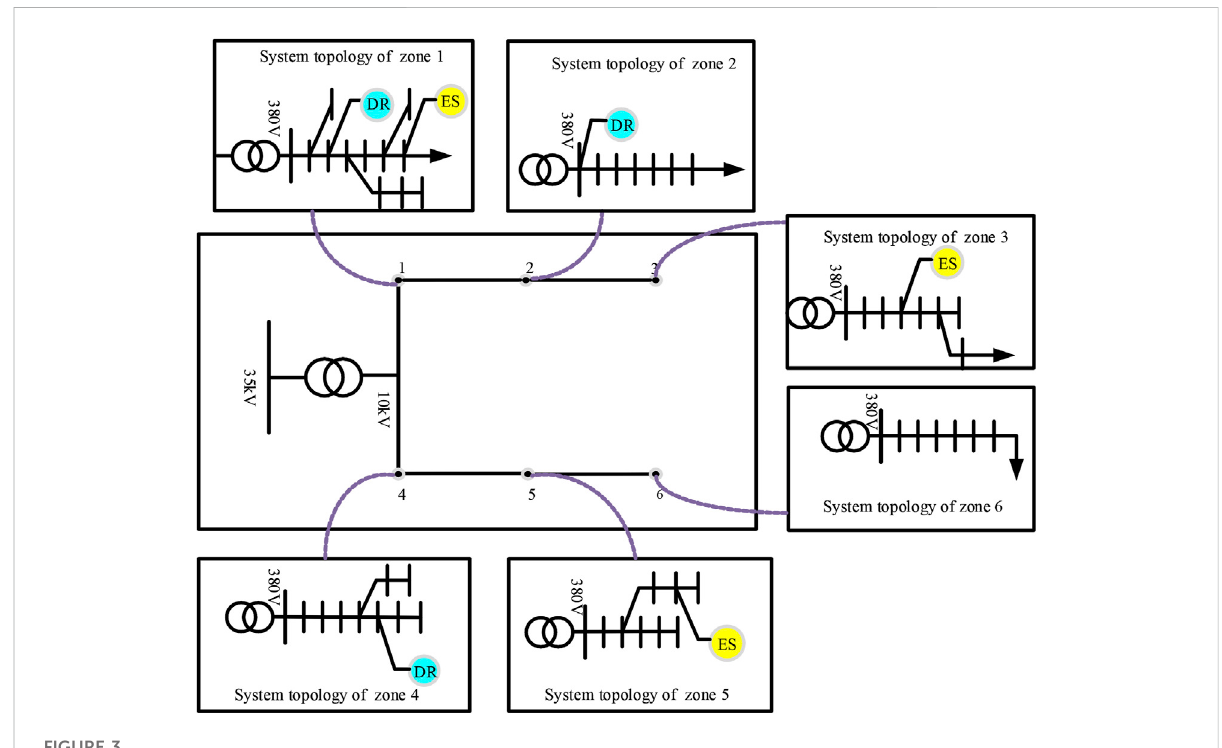
FIGURE 3 Network topology of distribution transformer supply zone cluster.